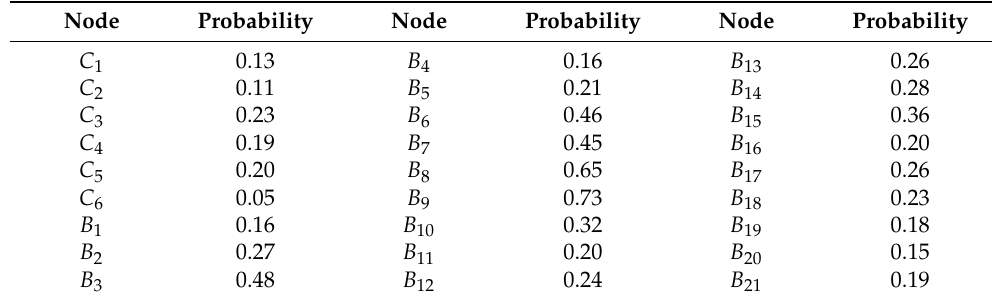
Table 10. Posterior probability of risk